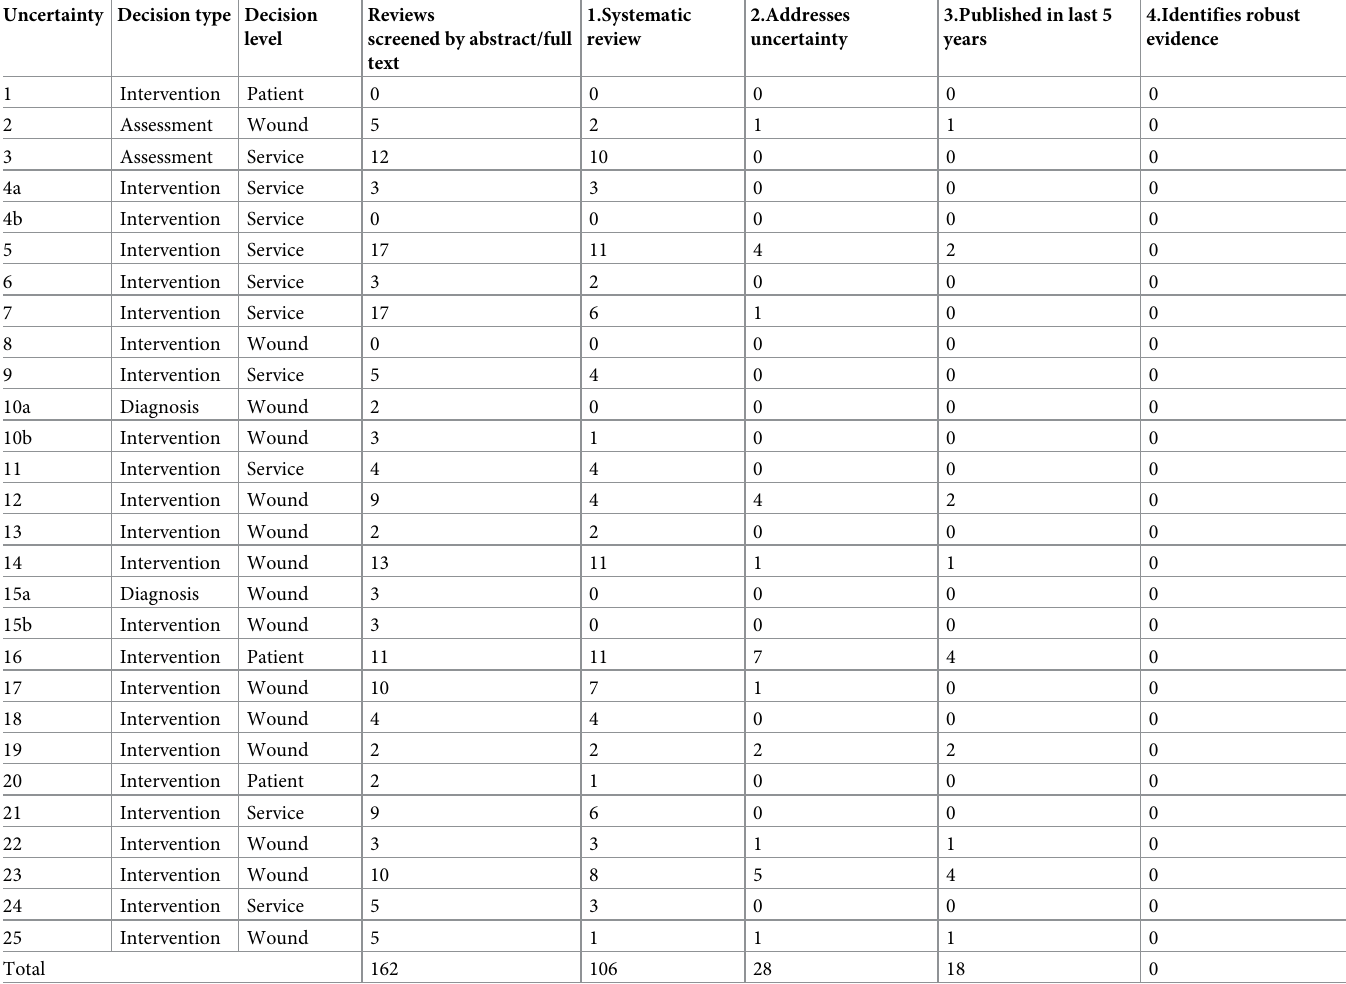
Table 4. Number of reviews screened and retained following application of each